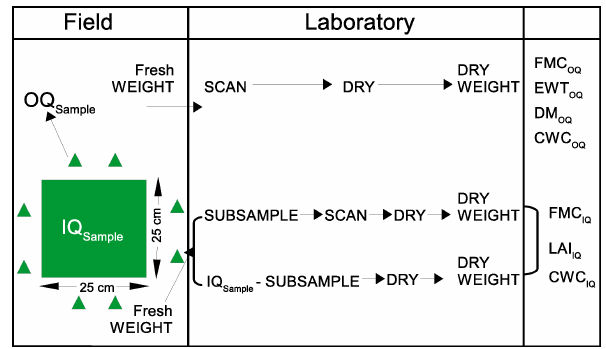
Figure 2. Scheme showing the different samples collected in the field and how they are processed in the laboratory. Metrics obtained as results are also indicated in the last